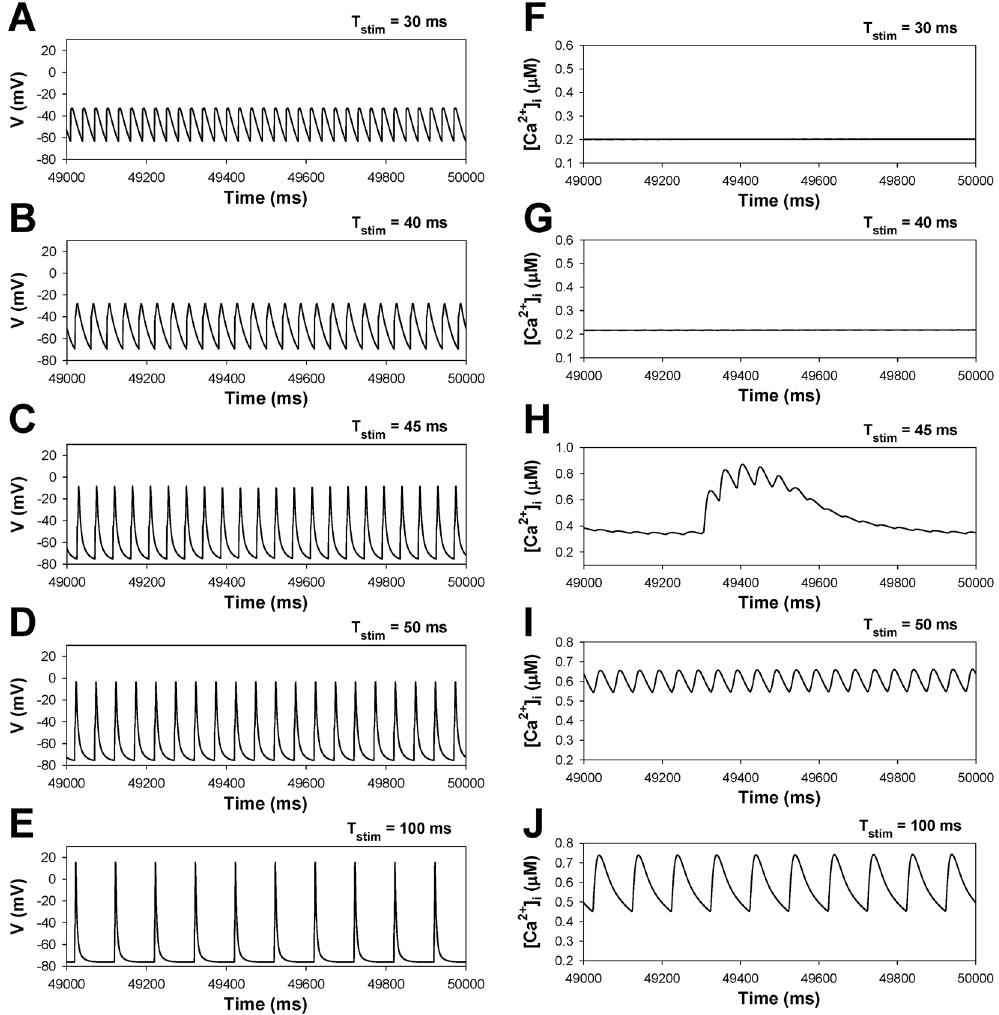
Figure 3. Simulated time series of AP (Panels A–E) and [Ca 2 + ] i transients (Panels F–J) in characteristic points of bifurcation diagrams for WT mouse ventricular myocytes in Fig. 2 during periodic stimulation: T stim = 30 ms (Panels A,F); T stim = 40 ms (Panels B,G); T stim = 45 ms (Panels C,H); T stim = 50 ms (Panels D,I); T stim = 100 ms (Panels E,J). Bursting [Ca 2 + ] i transients are observed at T stim = 45 ms (Panel H). I Na with slow